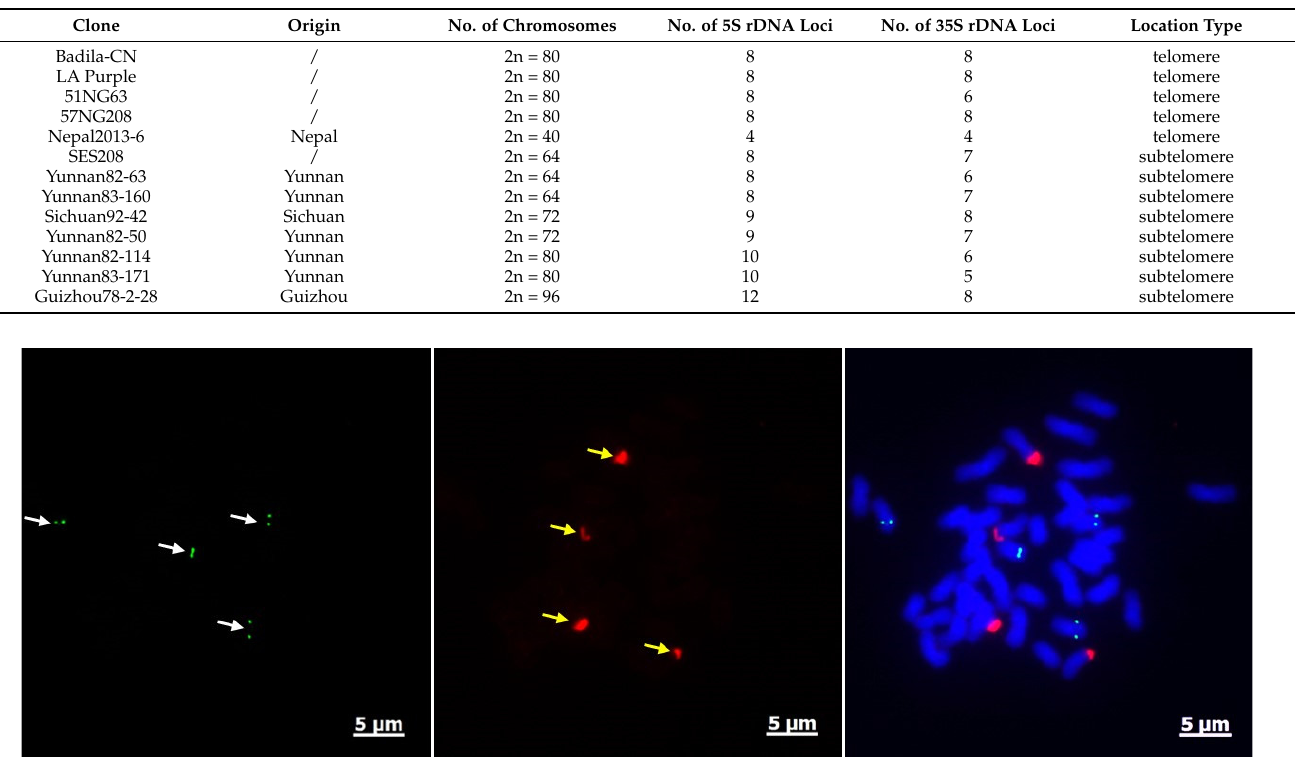
Figure 5. Localization of 5S rDNA and 35S rDNA probes on root–tip metaphase chromosomes of Nepal2013-6 (2n = 4x = 40) by FISH. The 5S rDNA signals are green and indicated by white arrows. The 35S rDNA signals are red and indicated by yellow arrows.